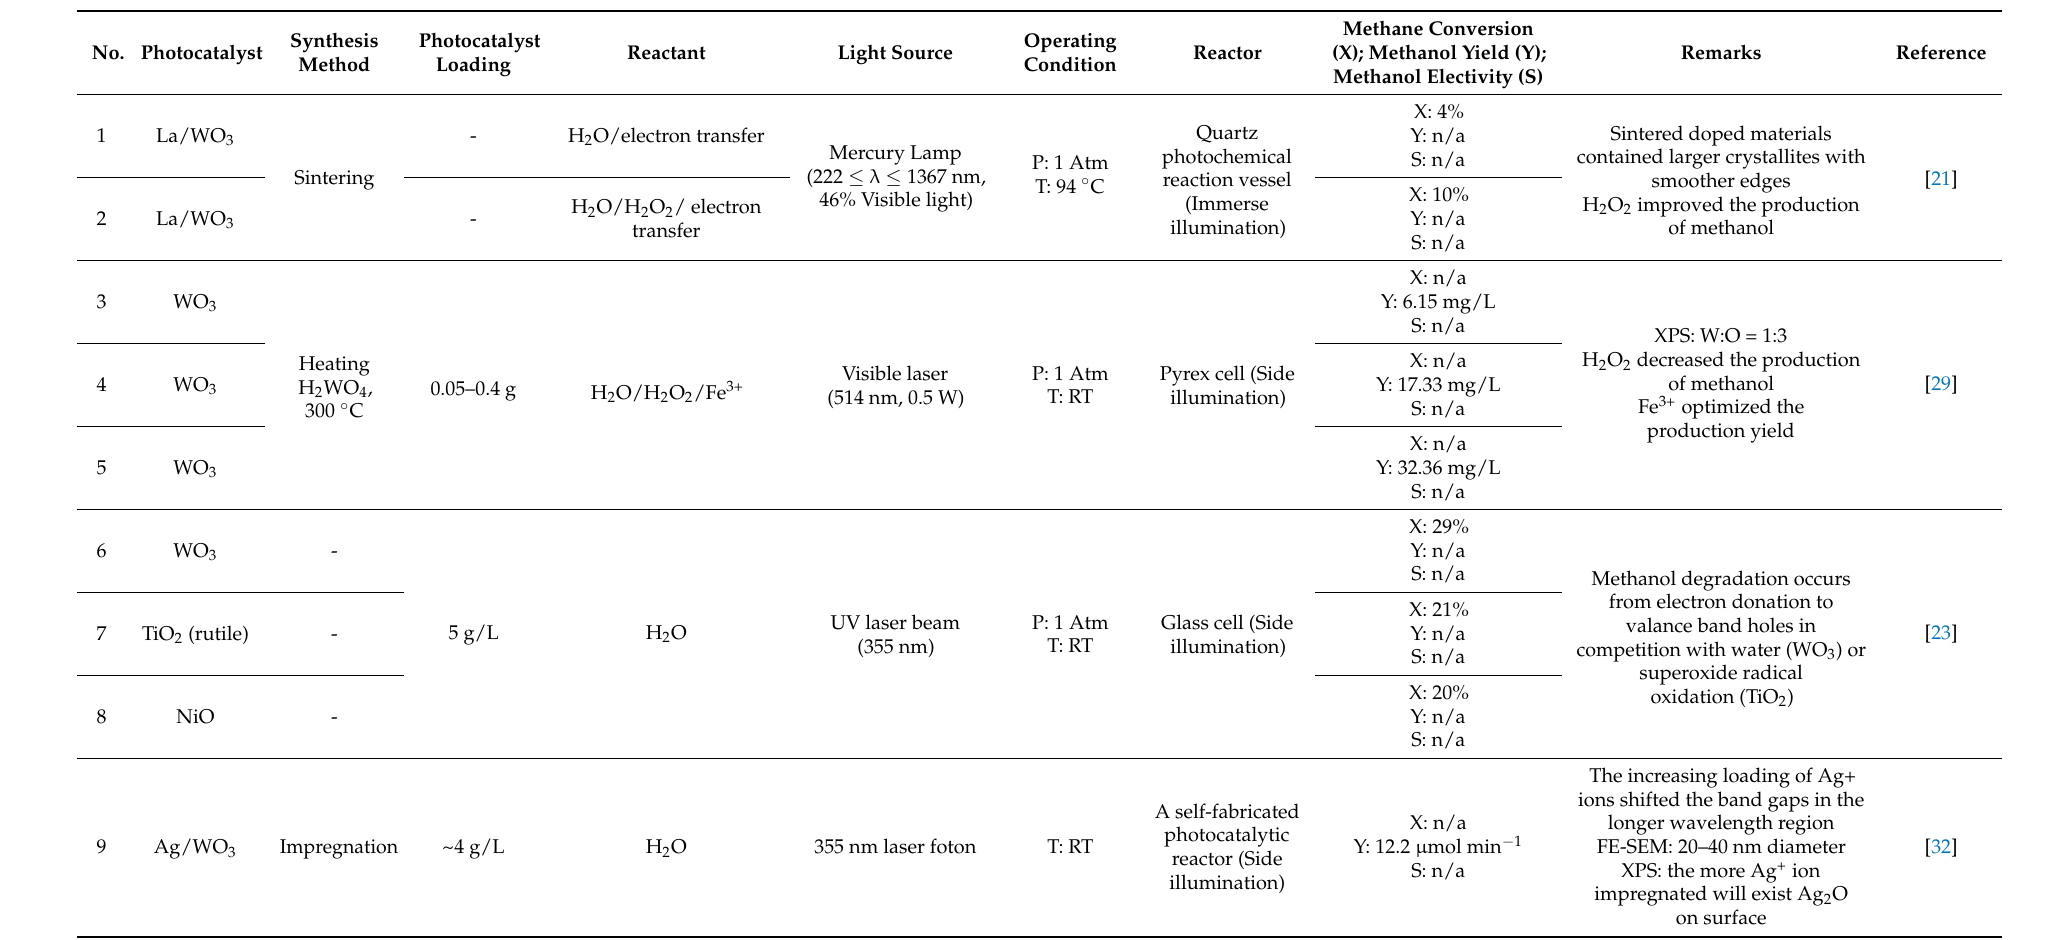
Table 3. State-of-the-art photocatalyst development for photocatalytic conversion of methane to